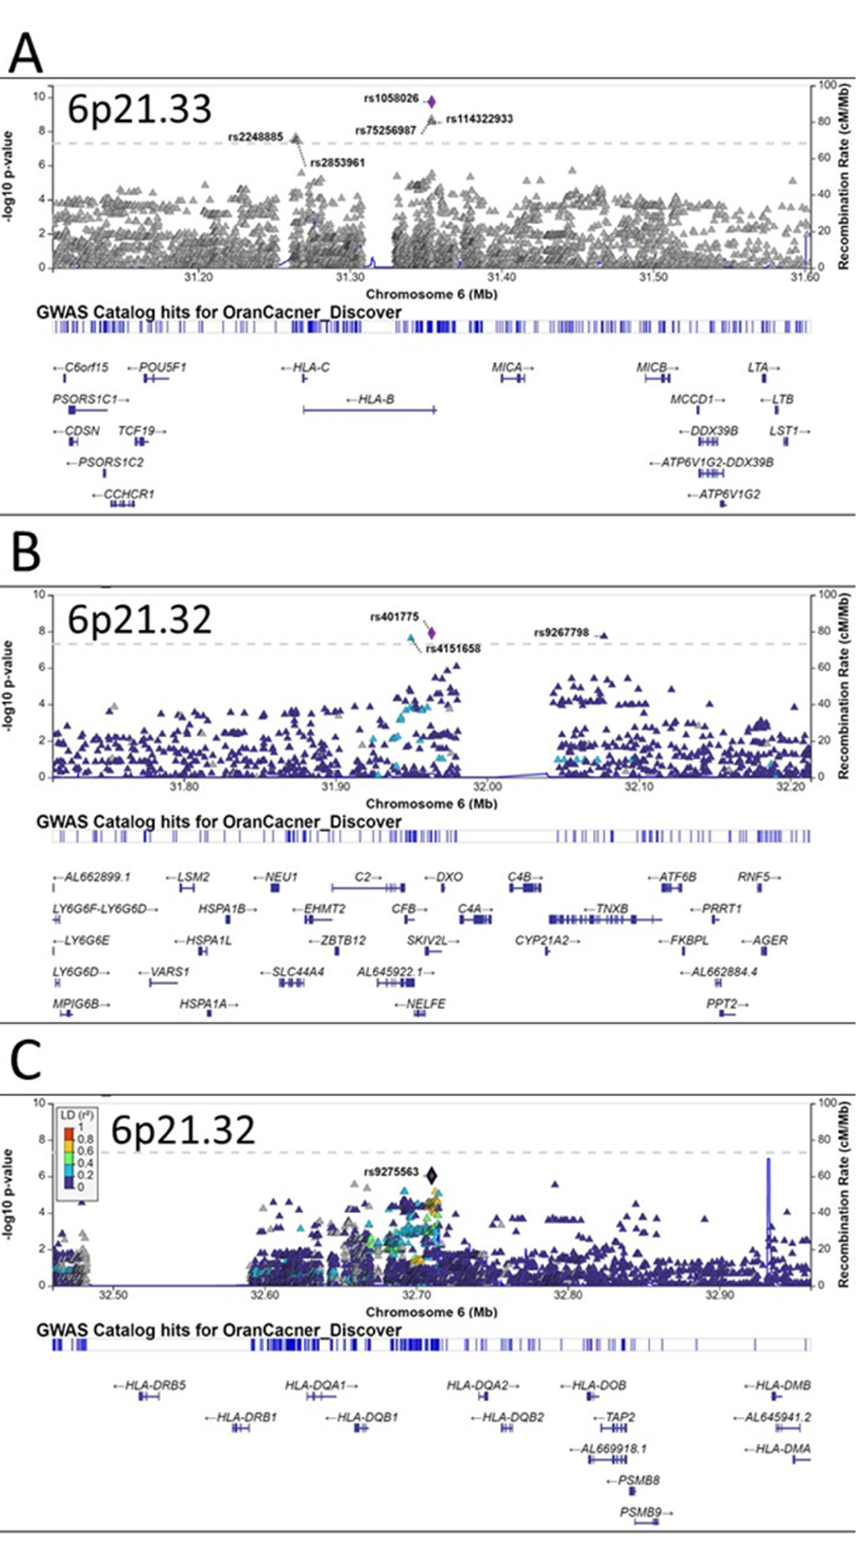
Figure 2. Regional plots of associations in 6p21. Three independent susceptibility loci for oral cancer are observed in 6p21 region ( A – C ). The y -axis presents the − log 10 p -values of the SNPs and the x -axis presents the corresponding chromosomal position of each SNP. The genomic locations of genes within the regions were annotated from the UCSC Genome Browser.